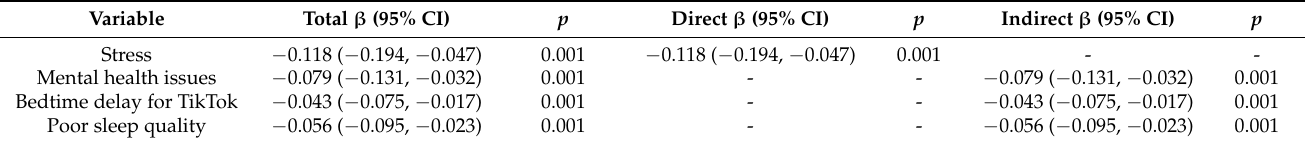
Table 3. Standardized total, direct, and indirect effects of physical activity (PA) on core variables.